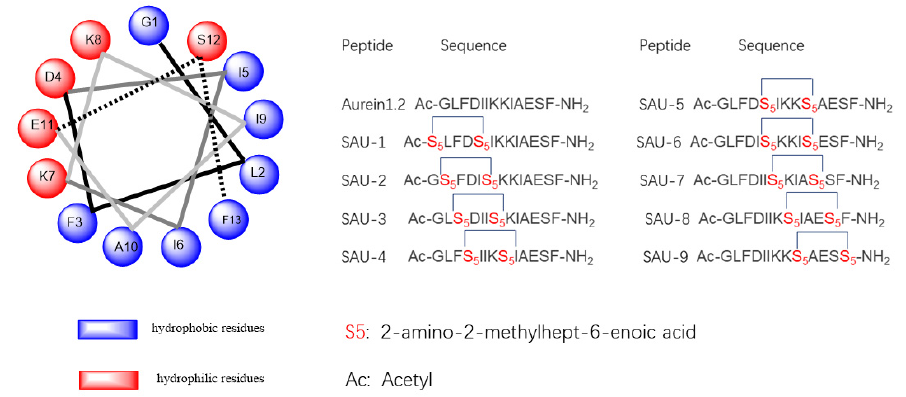
Figure 1. The sequences of Aurein1.2 and the stapled Aurein1.2